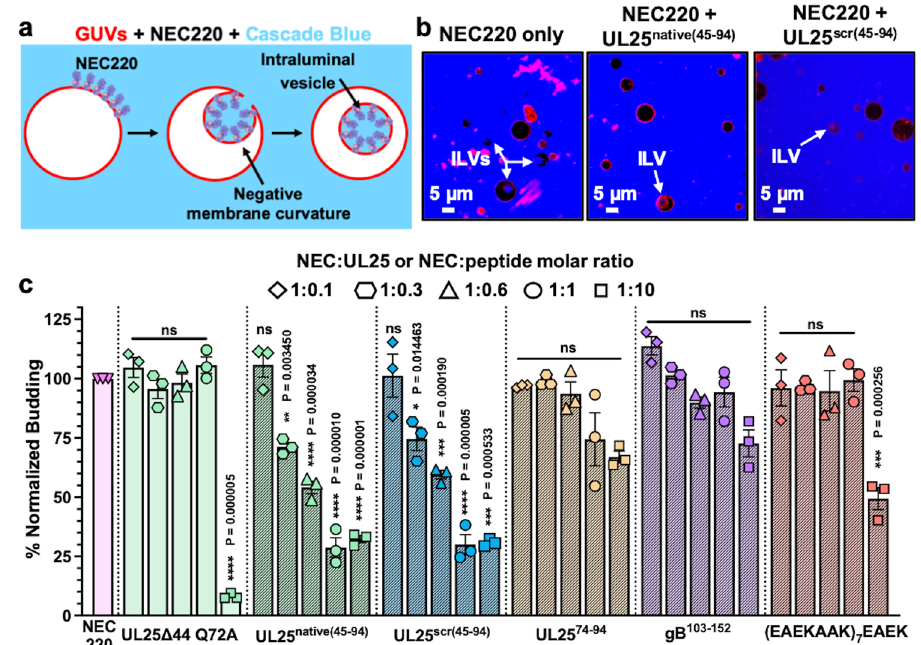
Figure 2. UL25 native(45–94) and UL25 scr(45–94) inhibit HSV-1 NEC-mediated budding in a dose-dependent manner. ( a ) A diagram of the NEC-mediated in-vitro budding assay generated in Microsoft PowerPoint. The NEC [PDB ID: 4ZXS] binds red fluorescent giant unilamellar vesicles (GUVs) in the presence of the membrane impermeable Cascade Blue dye, inducing negative membrane curvature, and generates intraluminal vesicles (ILVs) filled with Cascade Blue. The number of ILV-containing GUVs serves as a measure of budding efficiency. ( b ) Confocal microscopy images show ILVs formed inside the GUVs as the result of the NEC-mediated budding. Fewer ILVs are formed in the presence of UL25 native(45–94) or UL25 scr(45–94) due to inhibition of budding by the peptides. All images show the red (ATTO-DOPE) and blue (Cascade Blue) channels. Scale bars = 5 μm. ( c ) Quantification of the NEC-mediated budding in the absence or the presence of peptides or UL25∆44 Q72A. Budding was tested at 1:0.1, 1:0.3, 1:0.6, 1:1 or 1:10 molar ratios of NEC:UL25 or NEC:peptide. Each experiment was done in three biological replicates, each consisting of three technical replicates. Symbols represent average budding efficiency of each biological replicate relative to NEC220 (100%). Bars show the mean of three biological replicates, with error bars representing the standard error of the mean. Significance compared to NEC220 was calculated using an unpaired t -test. * P value < 0.05, ** P value < 0.01, *** P value < 0.001, and **** P value <